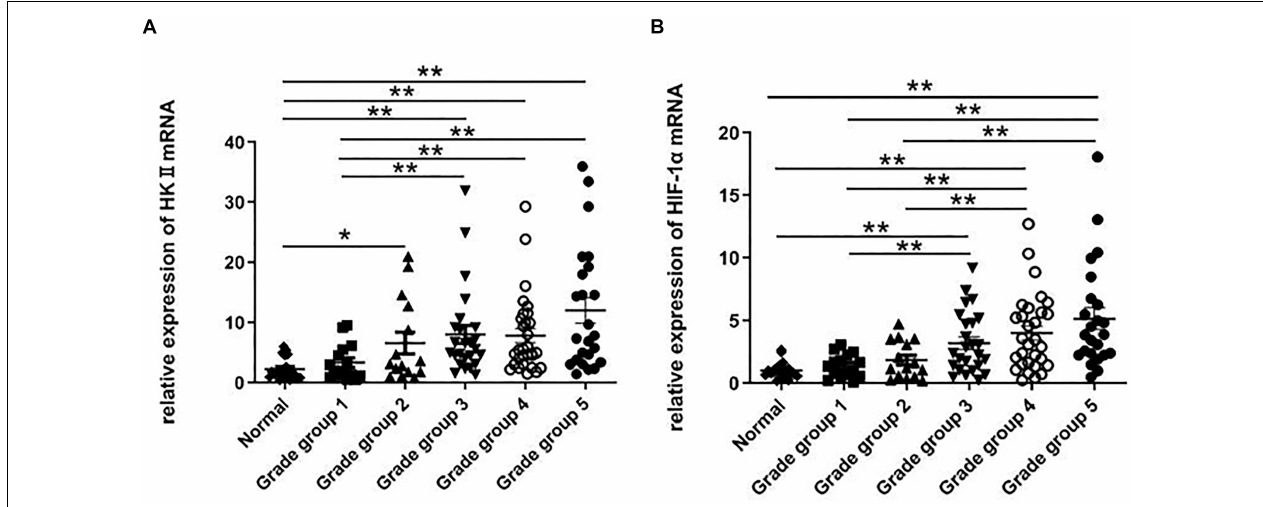
FIGURE 2 | RT-PCR was used to detect the expression of HKII and HIF-1 α in normal prostate tissues and different grade groups of tissues. The relative expression of HKII and HIF-1 α were normalized by β -actin, the ratios of HKII/ β -actin expression (A) and HIF-1 α / β -actin expression (B) were calculated from triplicate (* P < 0.05, ** P <